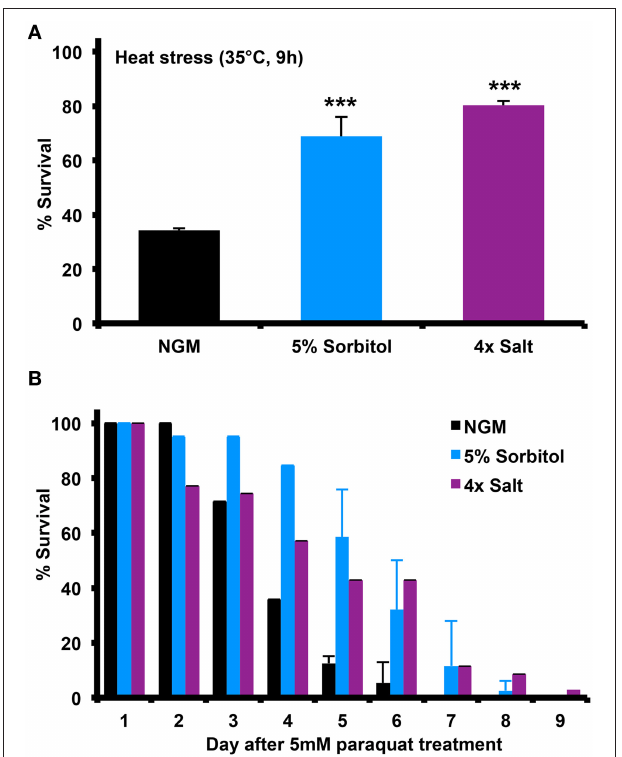
FIGURE 3 | Increasing the osmolarity of the growth medium with sorbitol increases nematode stress resistance. Addition of 5% sorbitol or 4X NaCl to NGM both significantly enhanced resistance to (A) heat shock stress, as assessed by survival following 9h at 35 ◦ C ( *** p < 0.05 , t -test), or (B) survival during exposure to the superoxide-generating agent paraquat